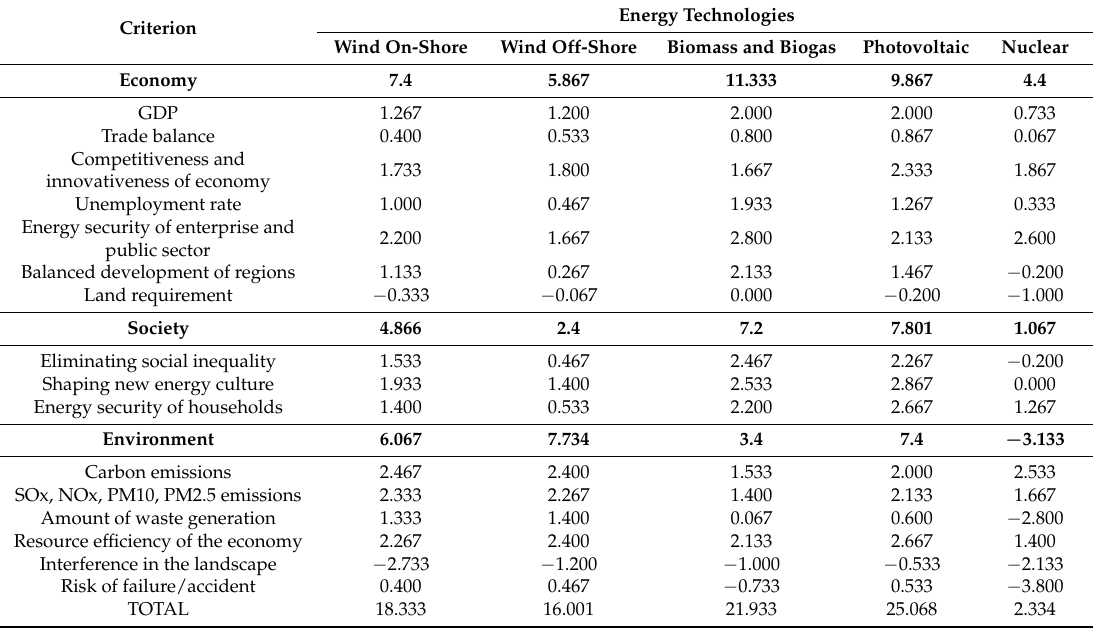
Table 7. Average scores for low-emission